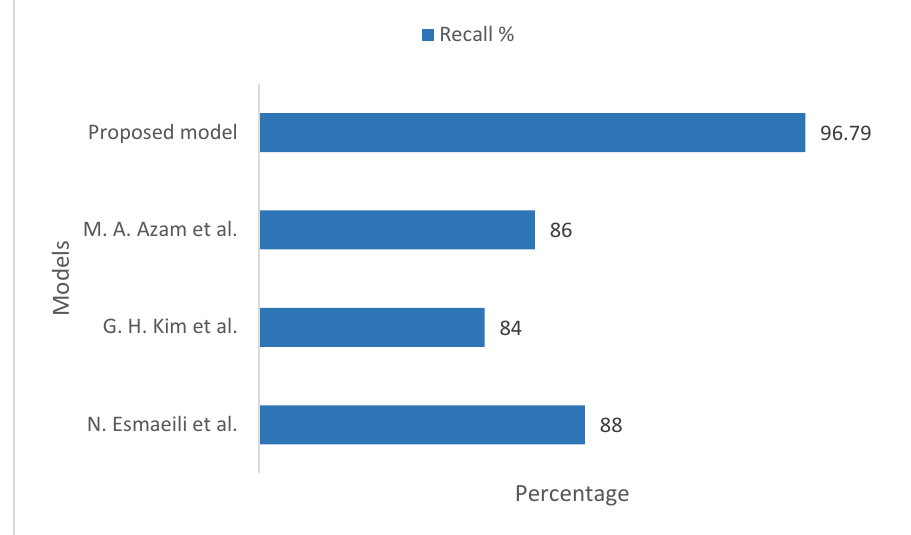
Figure 8. Recall comparison of the proposed model with existing models, taking into account the ImageNet datasets [33–35].